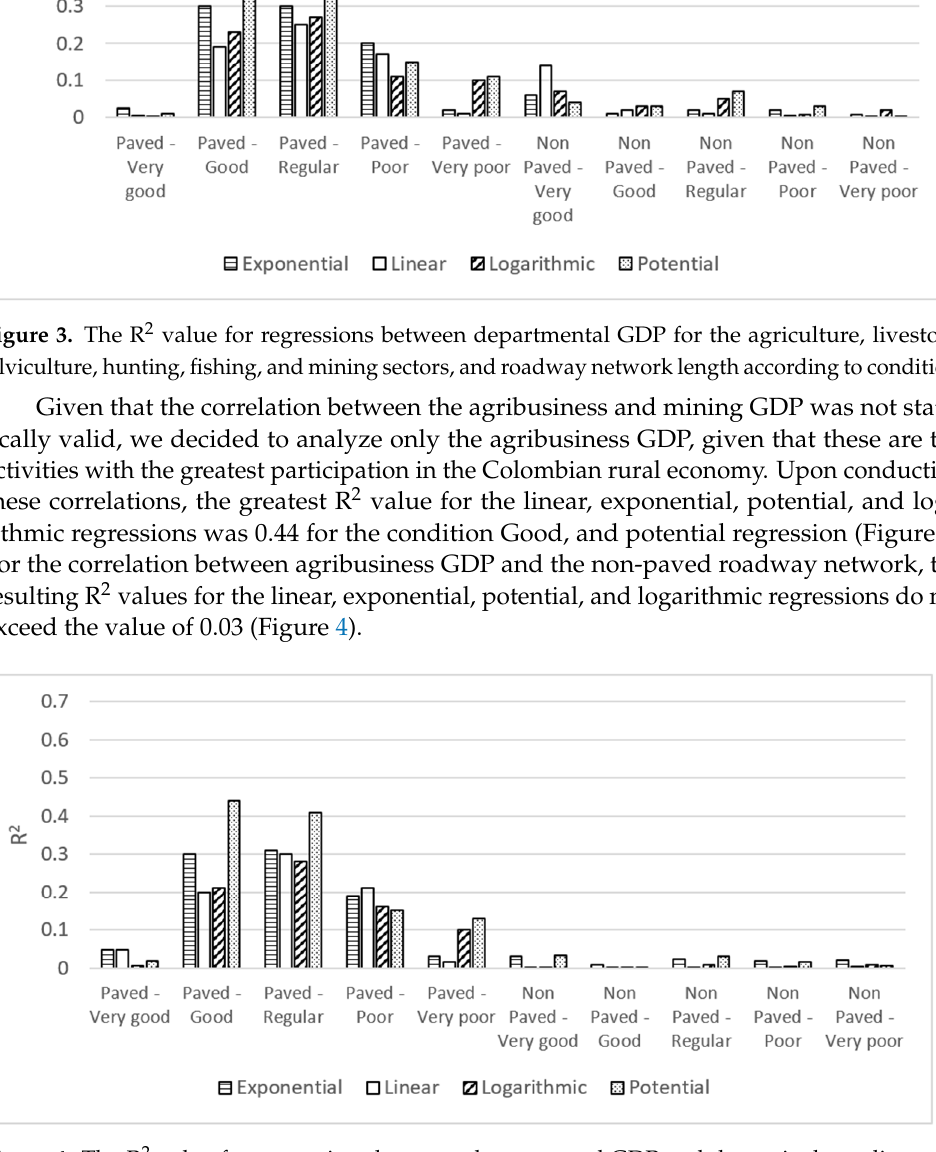
Figure 4. The R 2 value for regressions between departmental GDP and the agriculture, livestock, silviculture, hunting, and fishing sectors, and roadway network length according to condition.